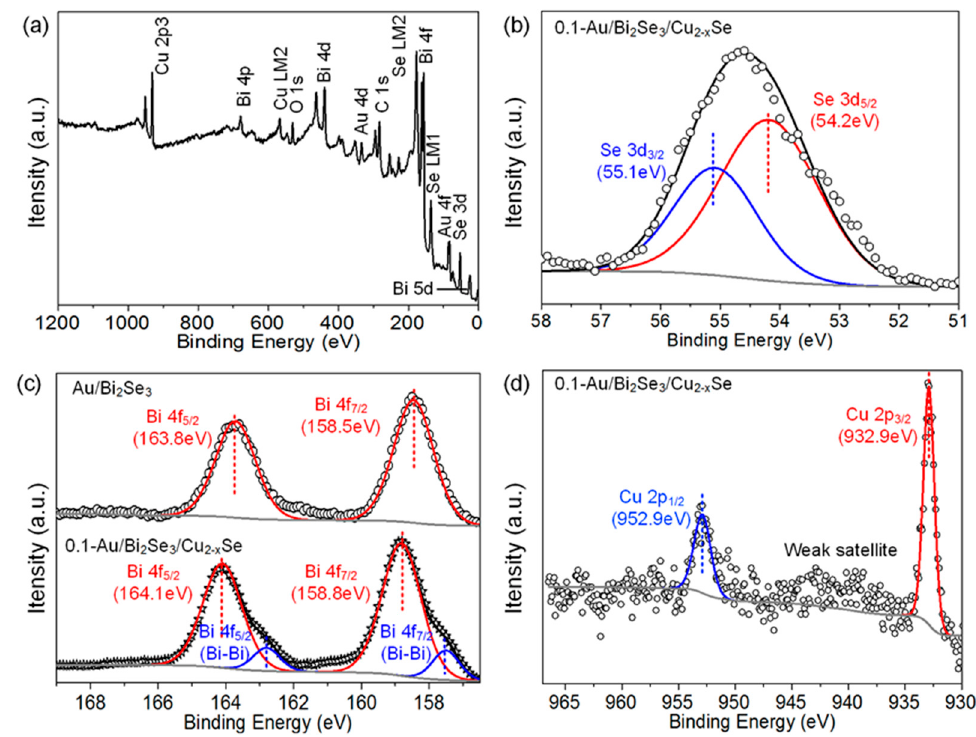
Figure 3. ( a ) XPS survey spectrum of Au/Bi 2 Se 3 /Cu 2 − x Se nanoparticles and high-resolution XPS spec- tra of Au/Bi 2 Se 3 and Au/Bi 2 Se 3 /Cu 2-x Se hybrids at binding energies corresponding to ( b ) Bi 4f, ( c ) Se 3d ( d ) and Cu 2p, respectively.